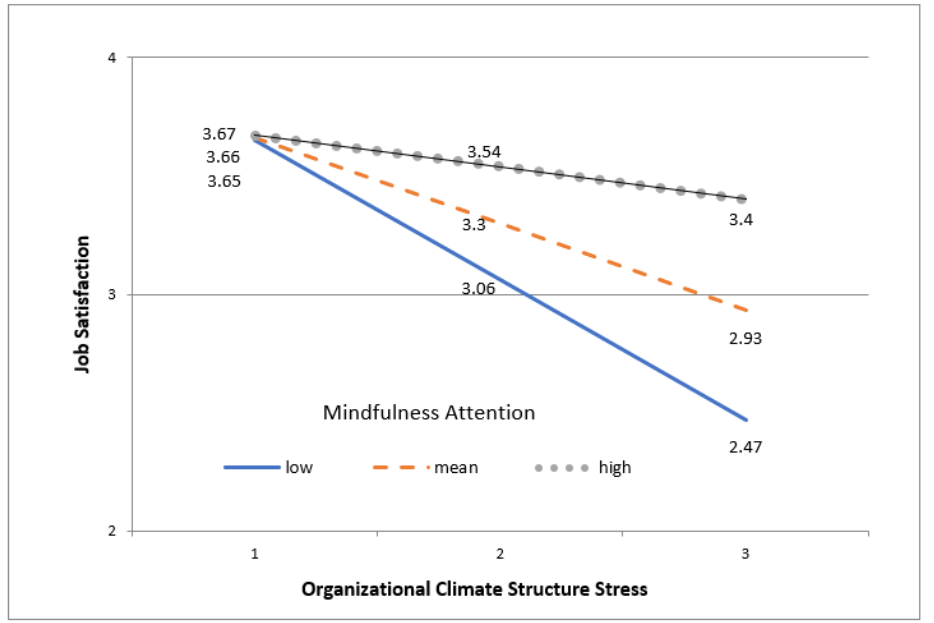
Figure 2. Interaction Between Climate (structure) and Mindfulness (attention) in the explanation of Variation in Job Satisfaction.